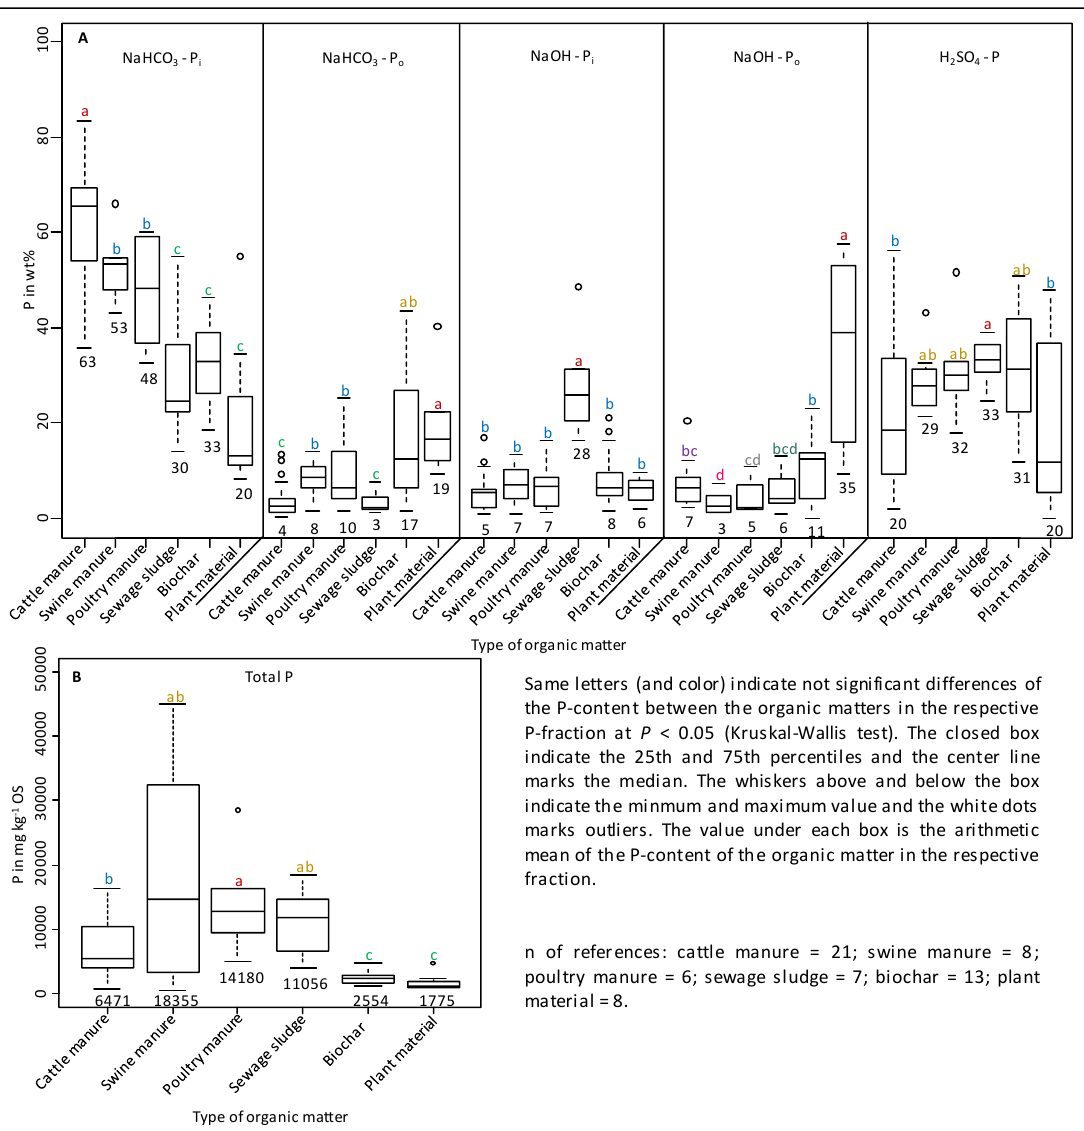
n of references: cattle manure = 21; swine manure = 8; poultry manure = 6; sewage sludge = 7; biochar = 13; plant material = 8.